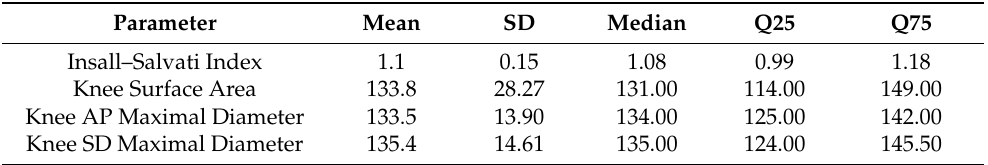
Table 2. Measurement characteristics of the group in terms of knee joint measurement results (SD: standard deviation, Q: quartile).